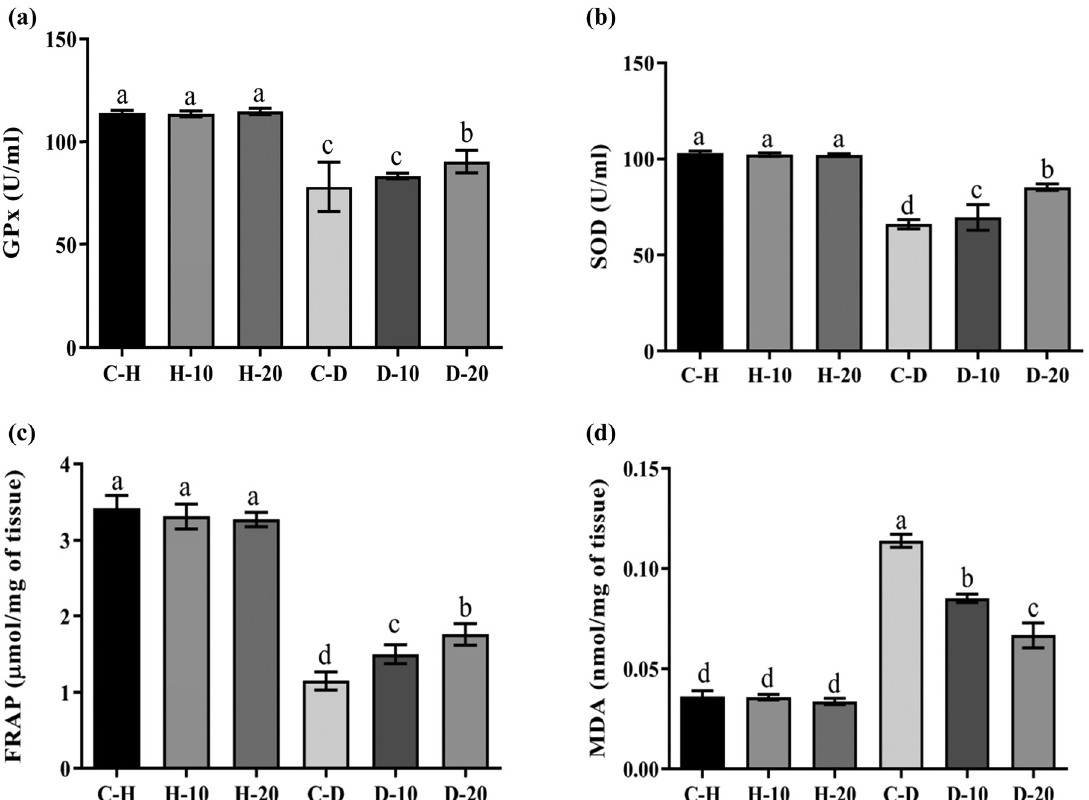
Figure 3: E ff ects of daily administration of NOM on the concentrations of GPx ( a ) , SOD ( b ) , FRAP ( c ) and MDA ( d ) in diabetic and non - diabetic rats. Di ff erent superscripts ( a – d ) show signi fi cant di ff erences between the groups. The results did not show signi fi cant di ff erences between healthy animals. The administrations of the NOM increased FRAP and decreased MDA compared with diabetic control in diabetic groups. C – H, H - 10 and H - 20 are healthy rats receiving 0, 10 and 20 mg/kg NOM, while C – D, D - 10 and D - 20 are diabetic rats receiving 0, 10 and 20 mg/kg